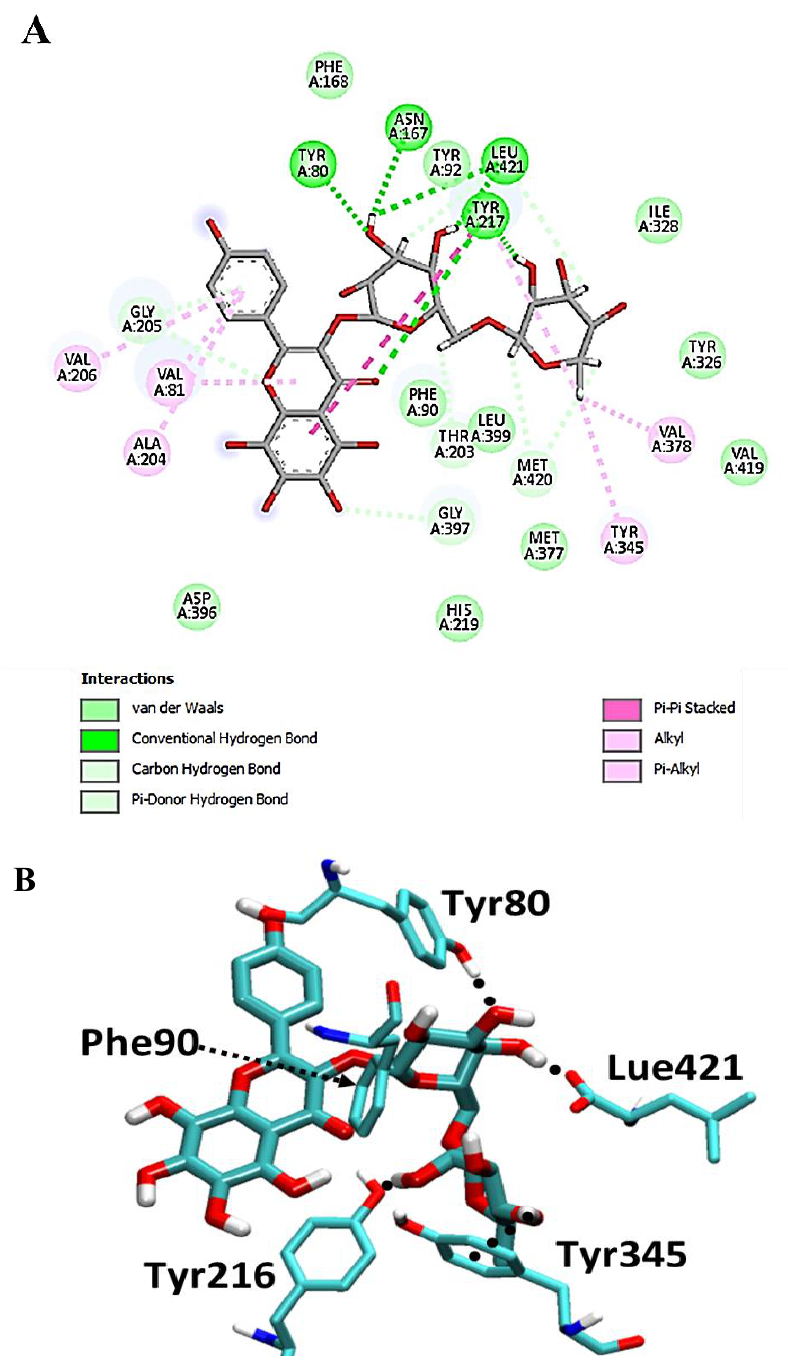
Figure 6. 2D and 3D interactions complex of calycopteretin 3-rutinoside with NMT (( A ) and ( B ), respectively).